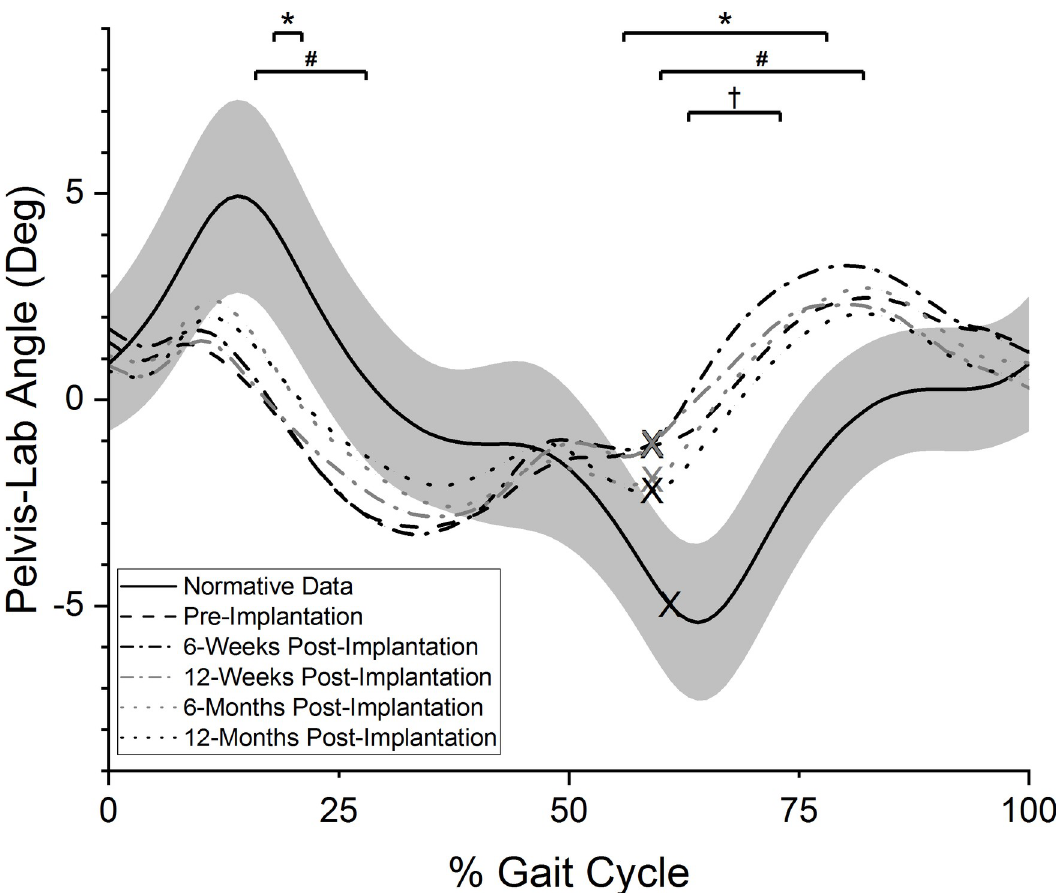
Fig 3. Frontal plane pelvis angle. Averaged, normalized frontal plane pelvis angle values over the prosthetic side gait cycle (0% = POP side heel strike, 100% = subsequent POP side heel strike). “X” marks represent the mean toe-off event for each curve. Positive values indicate ipsilateral pelvic hike relative to the lab space, while negative values indicate ipsilateral pelvic drop relative to lab space. Solid black line indicates reference values for individuals without TFA while grey band indicates plus or minus one standard deviation of the reference data. � : periods of statistically significant difference in pre-implantation test values from reference data (p = 0.05 and p = 0.01); #: periods of statistically significant difference in 6-week post-implantation test values from reference data (p = 0.05 and p = 0.01); †: period of statistically significant difference in 12-month post-implantation test values from reference data (p =